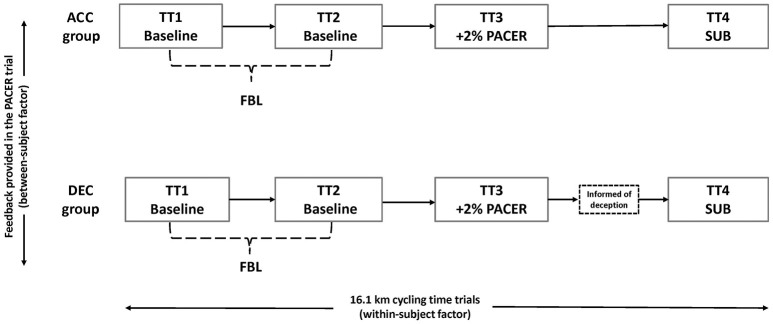
Trial schematic of the research design.